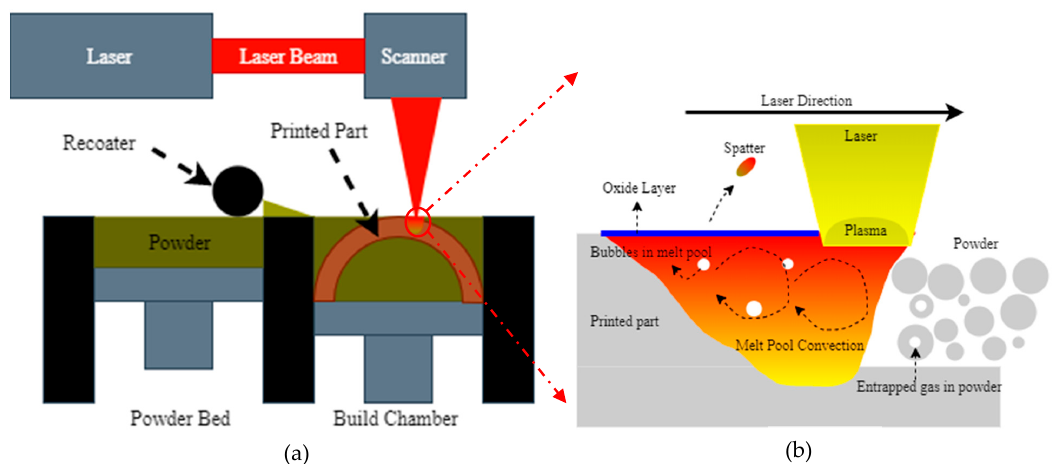
Figure 2. ( a ) Schematic diagram of L-PBF process [17], ( b ) Laser–melt interaction region [19].